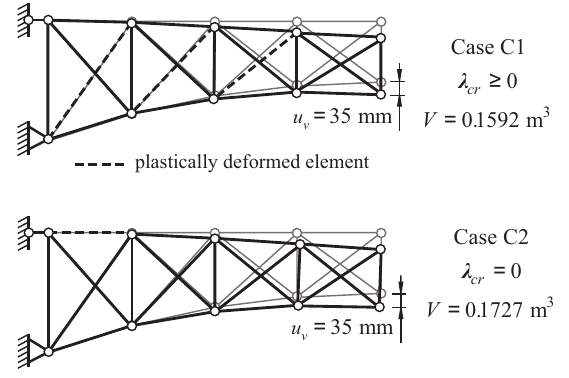
Fig. 3. Geometry and loading of the truss Fig. 4. Truss deformations and the optimal